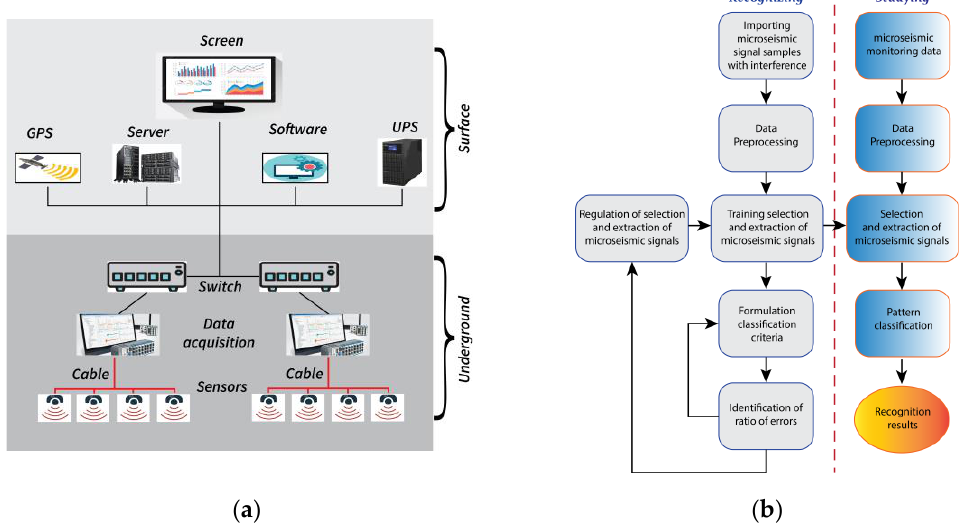
Figure 4. ( a ) In-situ monitoring for rockbursts: ( a ) Structure of microseismic monitoring system in a mine (modified from ref. [93]); ( b ) pattern recognition for microseismic signals (modified from ref. [92]).